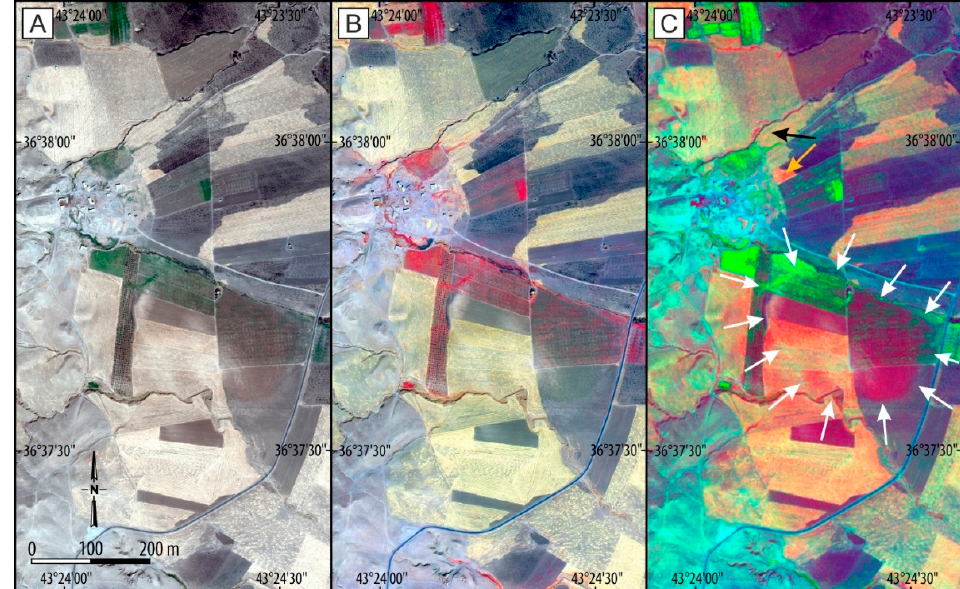
Figure 11. List of CCs: ( A ) C235 IHS in natural colors (TC), ( B ) FCC158 HPF, and ( C ) CC with decorrelation stretch obtained on bands 2, 3, and 5: the arrows indicate the obtained effects of content enhancement; the white and black arrows point to previously spectrally indistinguishable features; and white arrows indicate approximate boundaries of the extracted areal feature characterized by a differentiated spectral response (ID10300100388F8C00). WorldView-2 © 2014 DigitalGlobe, Inc., Westminster, Colorado, USA.